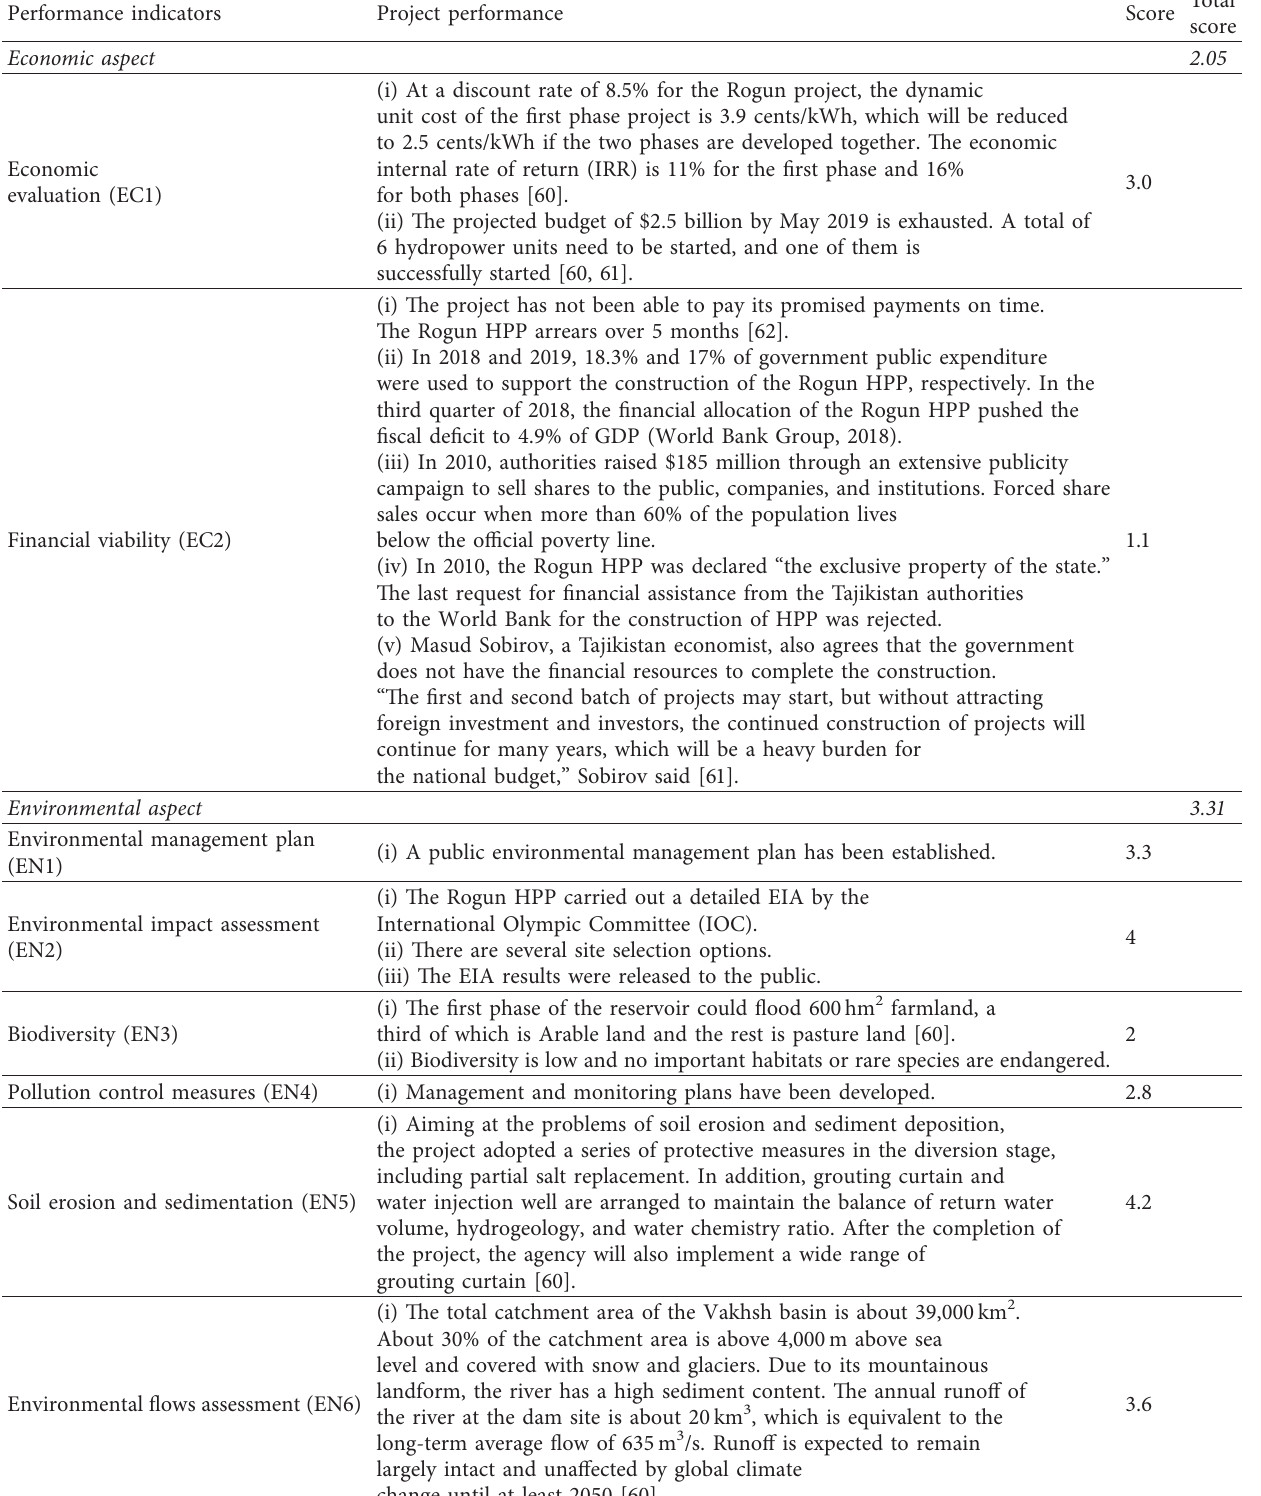
Table 4: The sustainability performance of Rogun